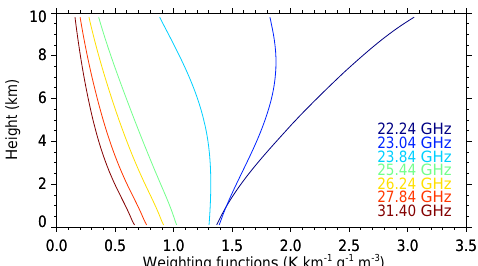
Figure 1. Absolute humidity weighting function for the HATPRO frequencies for a cloud-free model atmosphere.